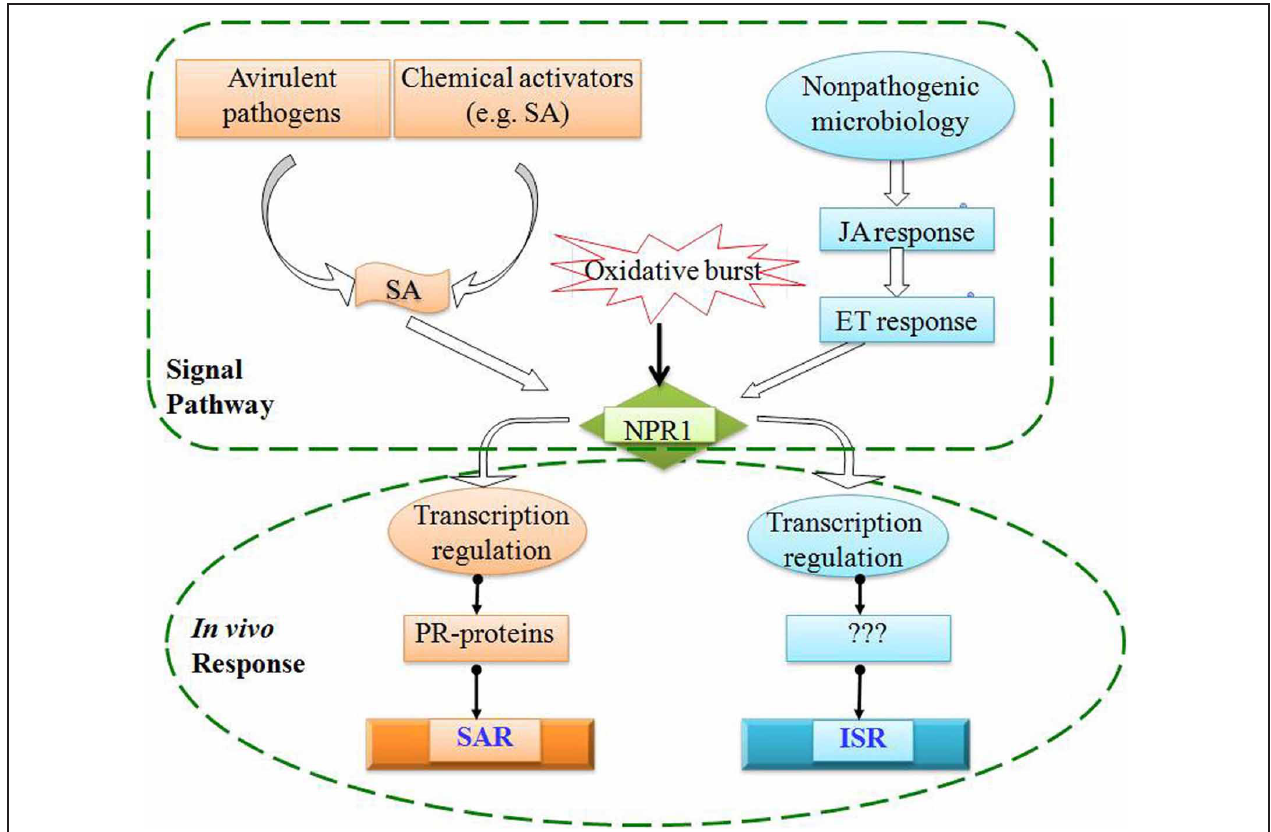
FIGURE 2 | Signal transduction pathways for systemic acquired resistance (SAR) and induced systemic resistance